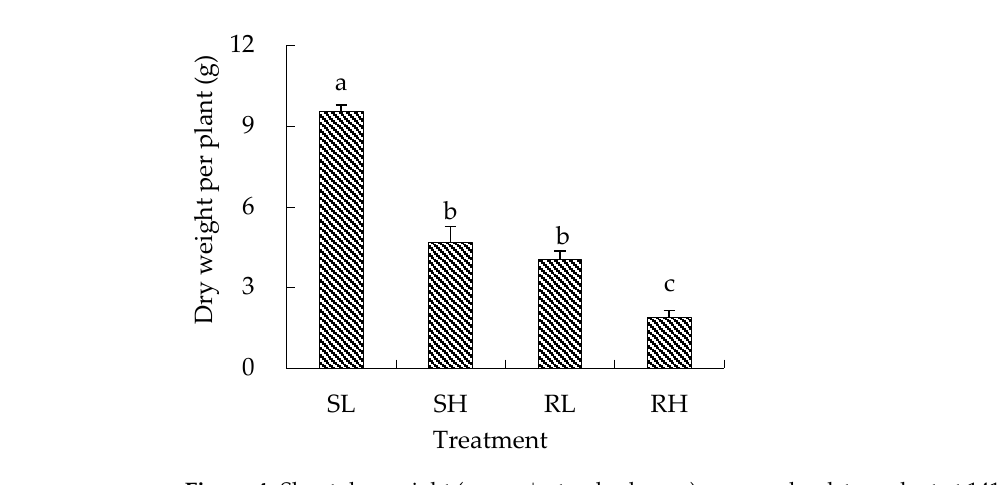
Figure 4. Shoot dry weight (mean ± standard error) per eared redstem plant at 141 DAS. The letters L and H refer to low and high eared redstem densities, respectively. The letters S and R refer to BSM-susceptible and BSM-resistant biotypes, respectively. Different letters above columns indicate significantly different means ( p < 0.05).